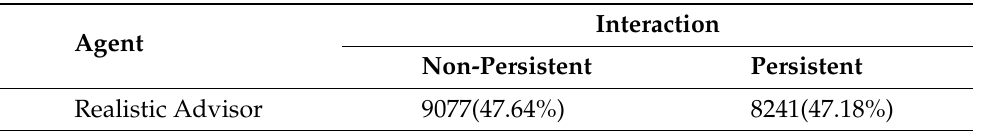
Table 3. The average number of interactions in the experiment and the percent compared with the total steps taken for the realistic agent in the Webots environment.